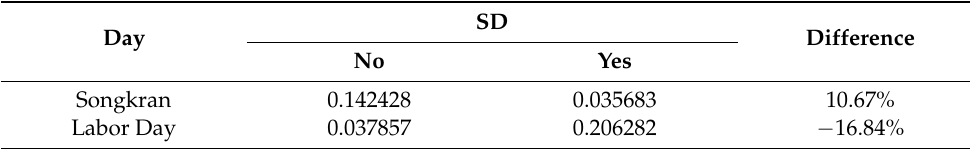
Table 12. Target days in which SD had significant impacts on APE.